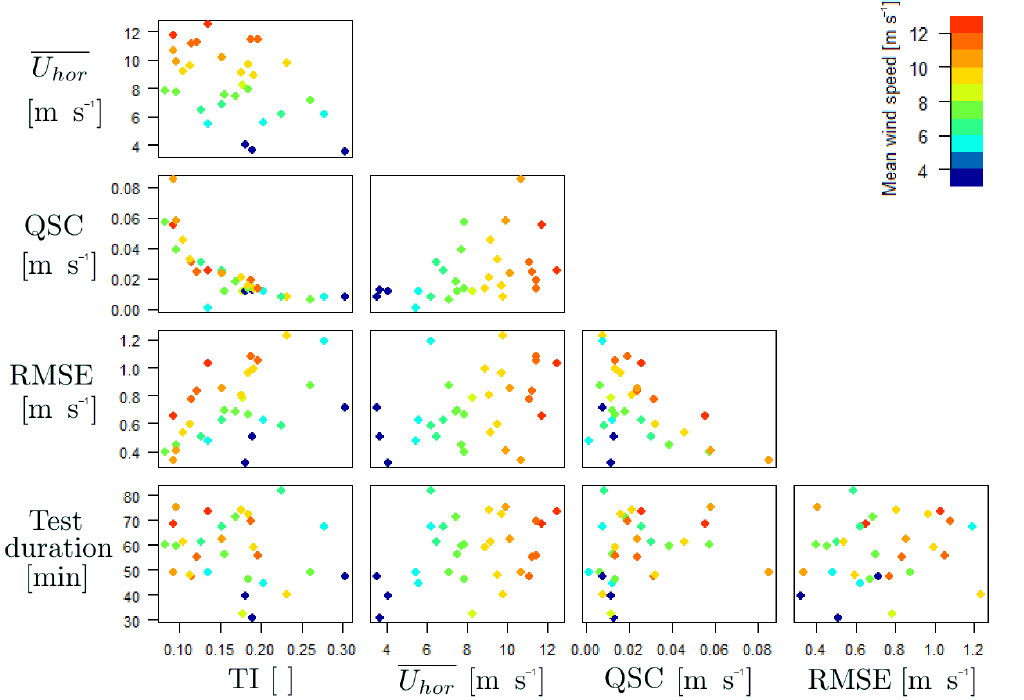
Figure 8. Application of the method to a large database of wind turbines. Colour-coded according to the mean wind speed.